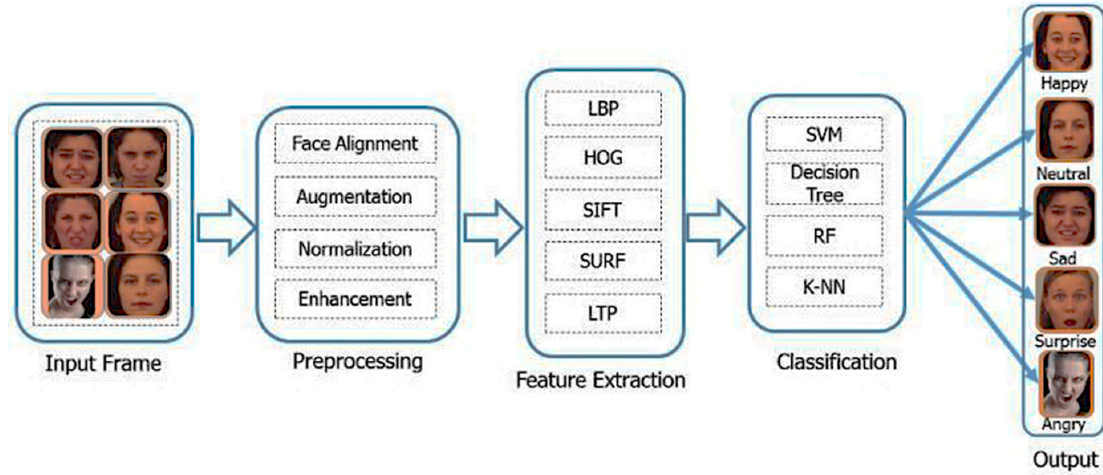
Figure 1. Facial emotion recognition (FER) process.